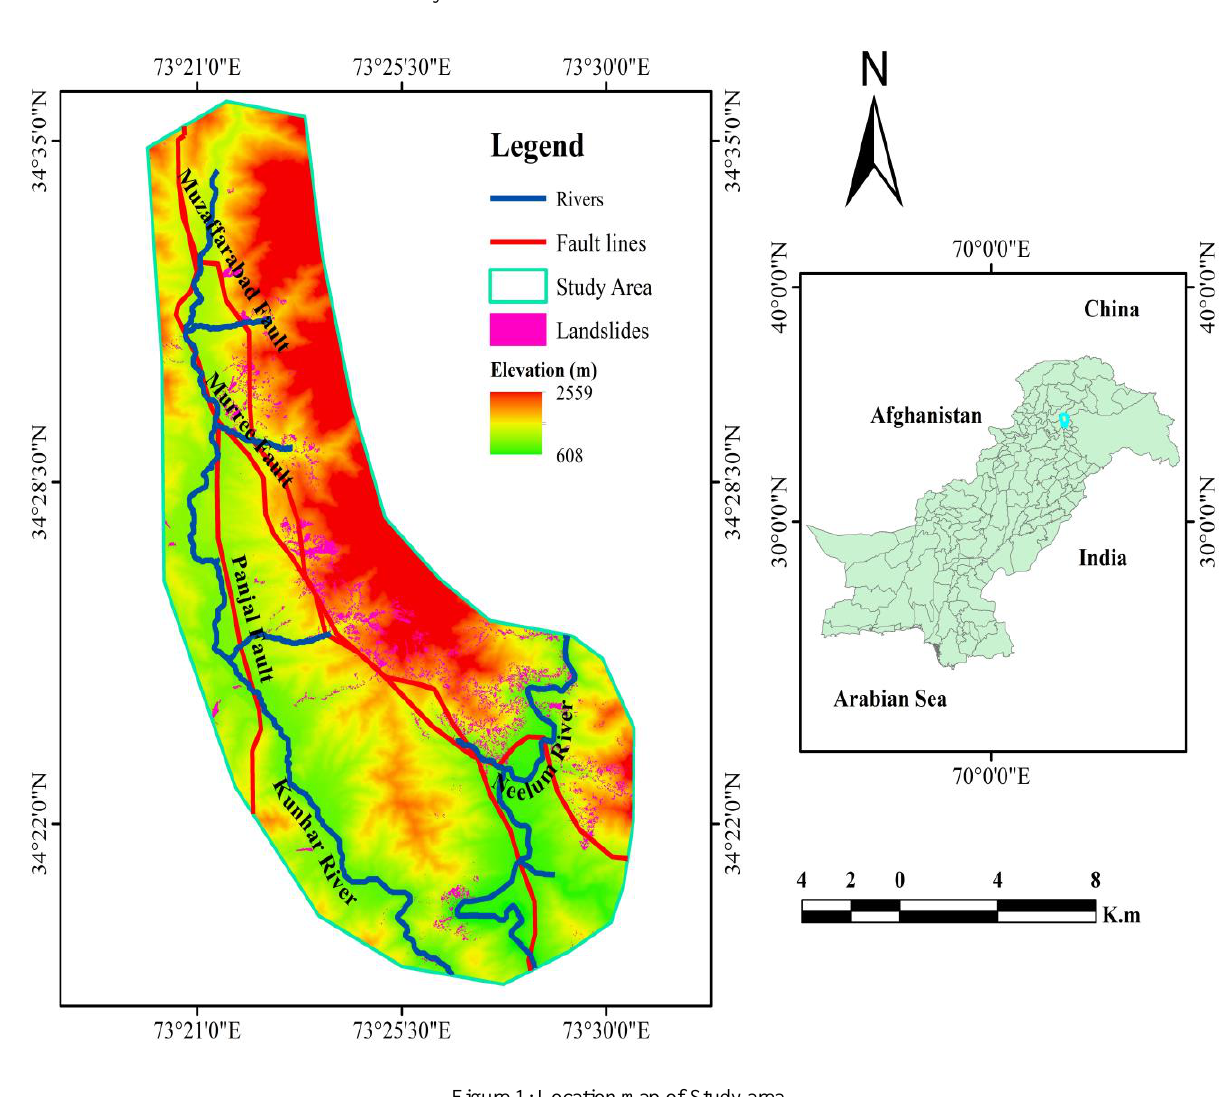
Figure 1: Location map of Study